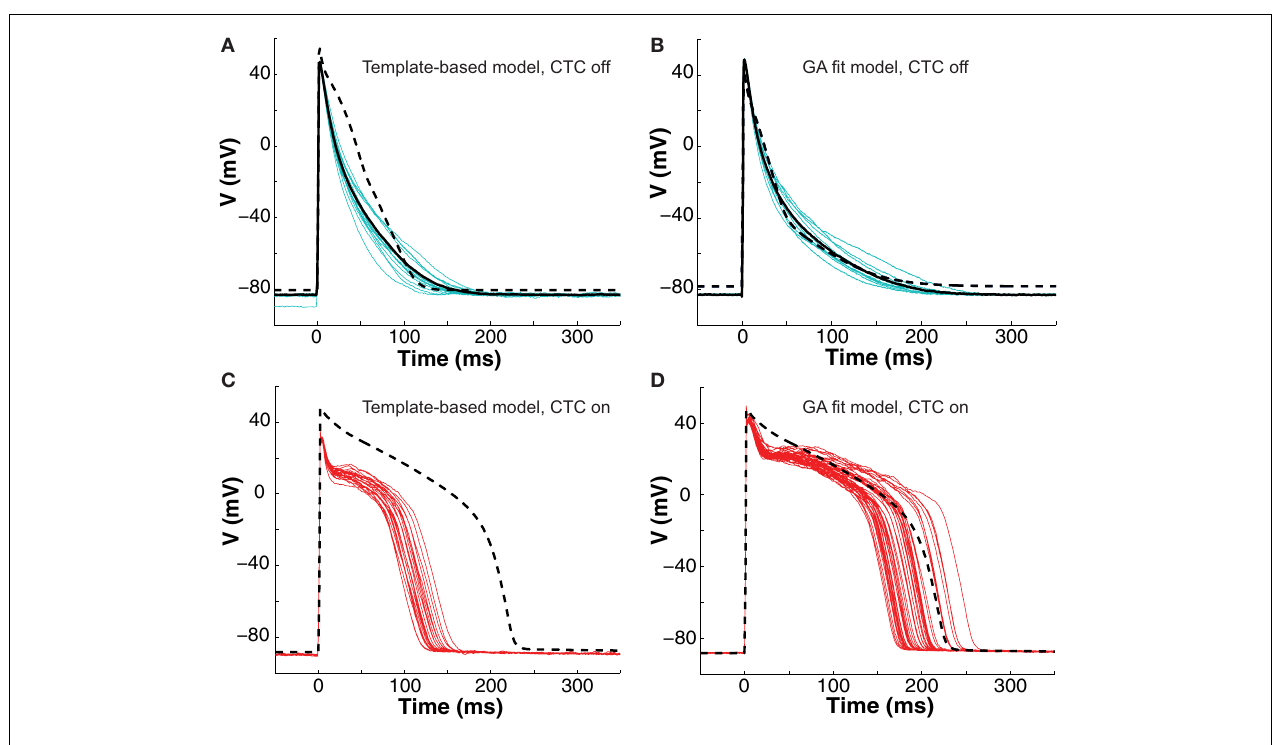
objective.The GA returns a close fit (dashed line). (C) With CTC on, template-based target-canceling model selection resulted in APs (red traces; 20 subsequent APs) morphologically similar to the recipient guinea pig model AP (dashed line), but of much shorter duration. (D) Applying CTC using the GA-optimized model gave guinea pig-like action potentials (red traces; 40 subsequent APs) that mimic the recipient cell model prediction (dashed